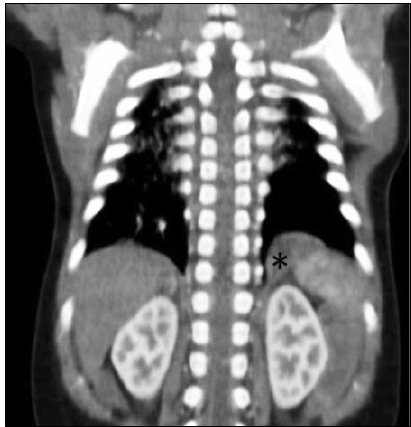
Figure 3: Postnatal computed tomography image showing over inflation in the lower part of the inferior lobe with a solid epi- diaphragmatic mass